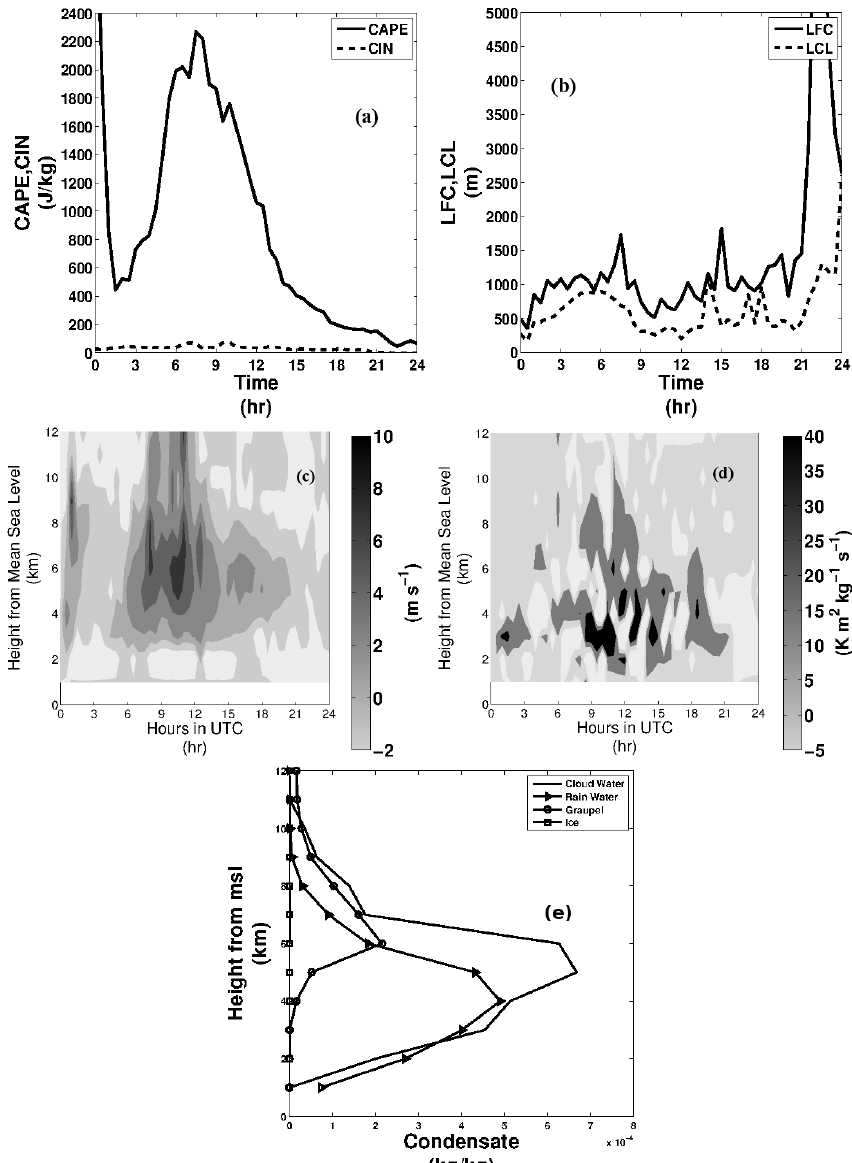
Figure 8. Model-simulated (a) CAPE and CIN, (b) LCL and LFC, (c) updraft and downdraft, (d) potential vorticity, and (e) microphysical classes (cloud water, rainwater, graupel, and ice) for Uttarkashi during 3 August 2012.